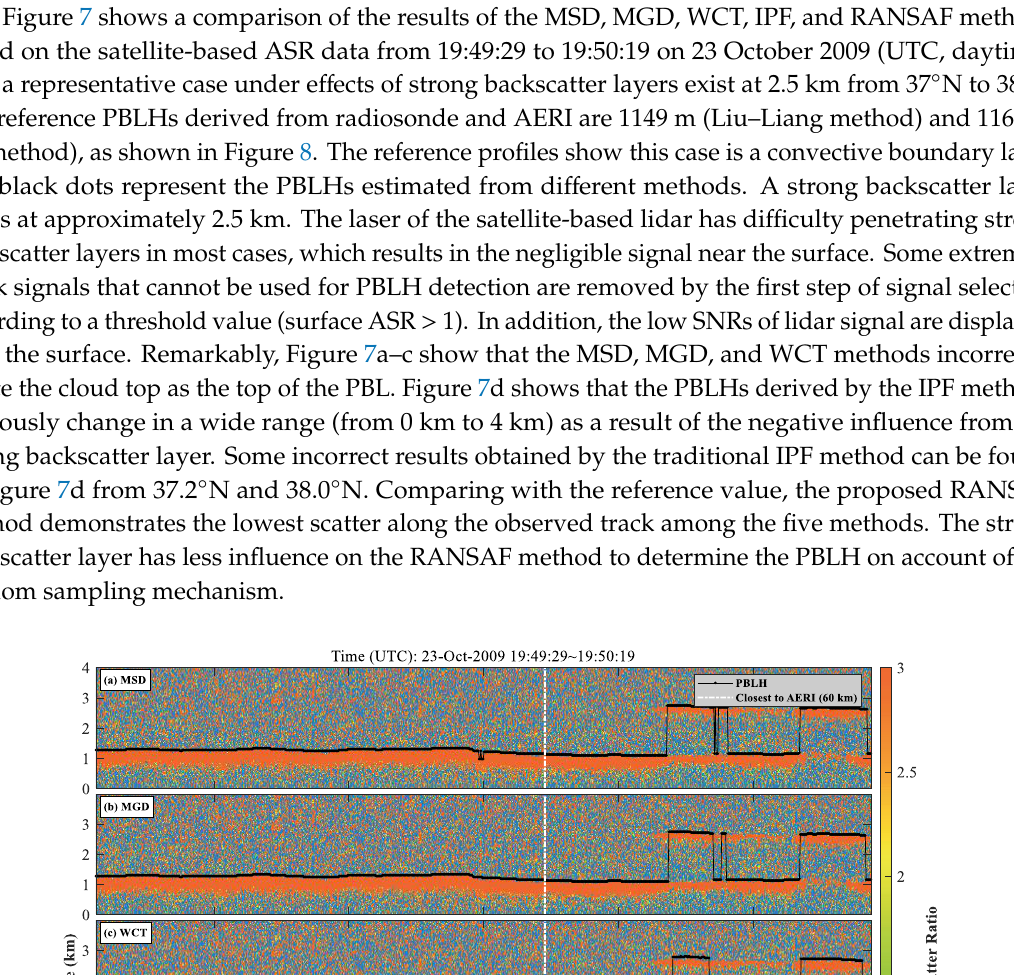
Figure 8. PBLHs were determined with the ( a ) radiosonde (RS) at 17:28 and ( b ) AERI at 19:43 on 21 October 2009 (UTC); ( c ) ARM SGP site of radiosonde observations and CALIPSO trajectory. The minimum distance between the CALIOP and radiosonde (AERI) measurements are shown in the top of subfigure ( c ).